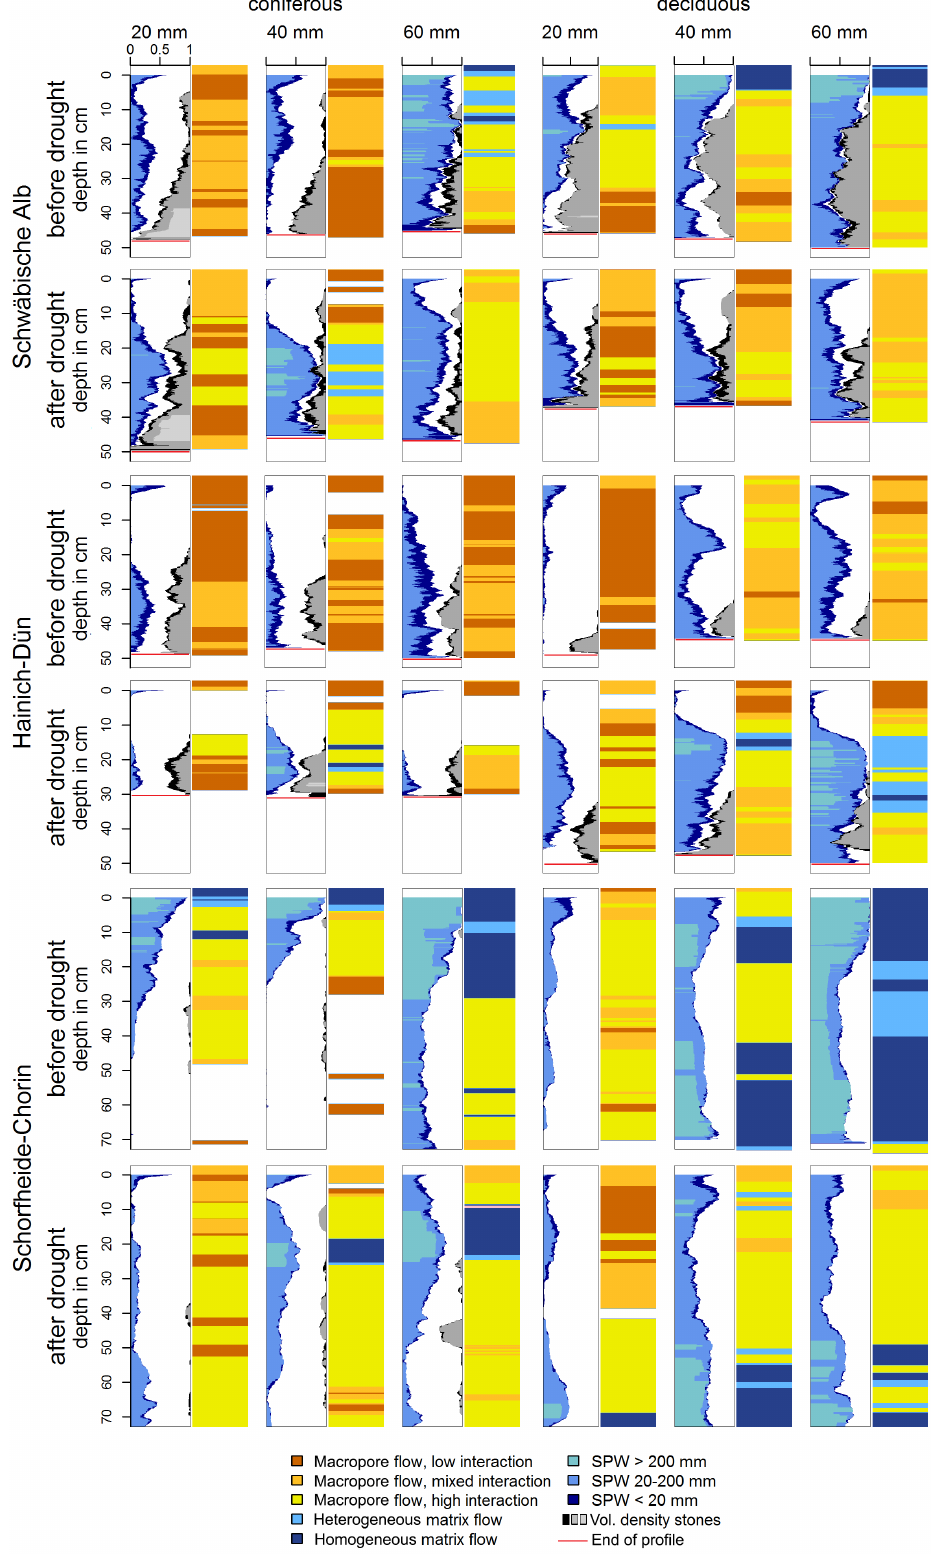
Figure 8. Comparison between before drought (2011) and after drought (2013) stained path widths (SPWs) and flow processes for coniferous and deciduous stand plots. The sum of SPW is the volume density (VD) per depth. Grey and black indicate the VD of